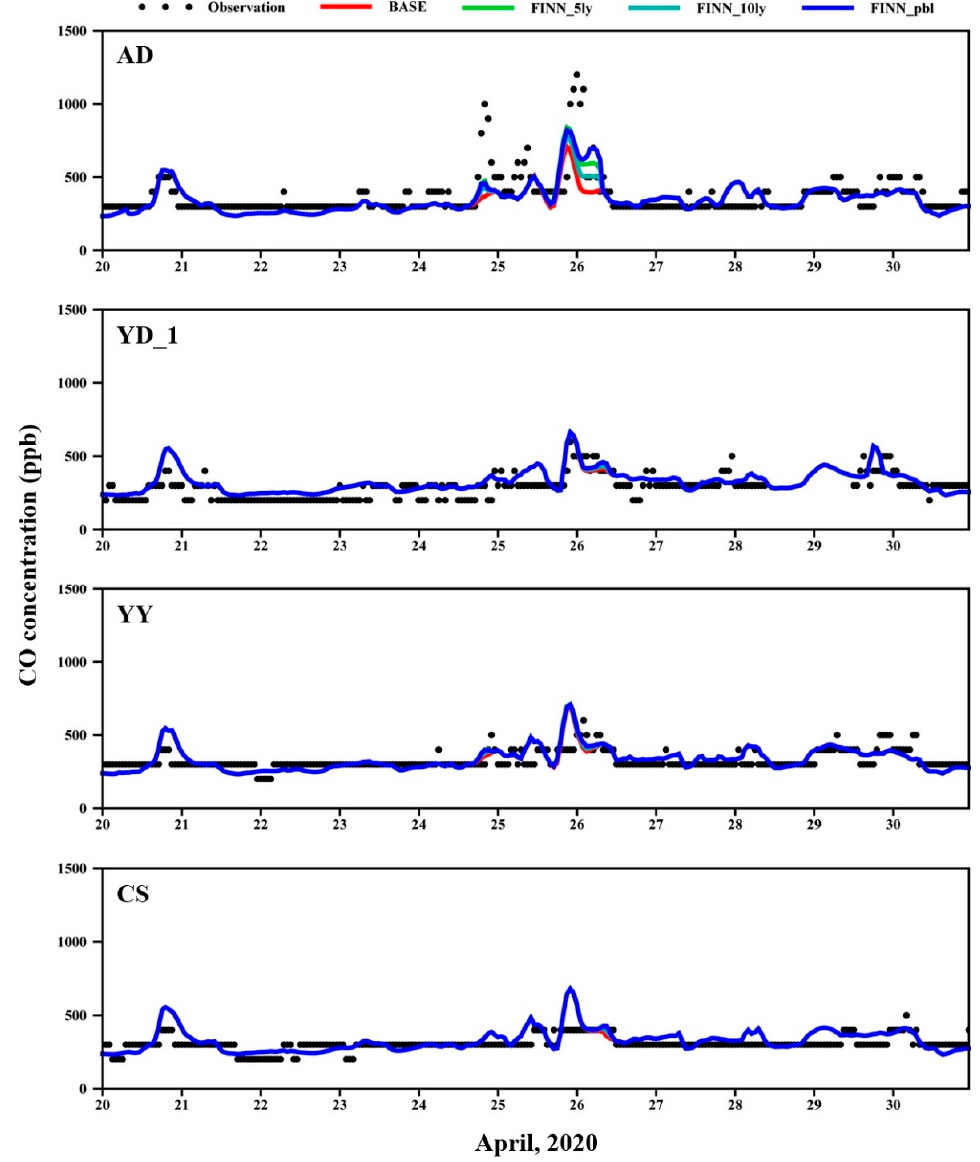
Figure 4. Comparison of observed CO concentrations at AQMS sites in Figure 3 (AD, YD_1, YY, CS) and results of CMAQ numerical simulations (BASE, FINN_5ly, FINN_10ly, FINN_pbl) from 20 to 30 April 2020 (site YD_2 has missing data).